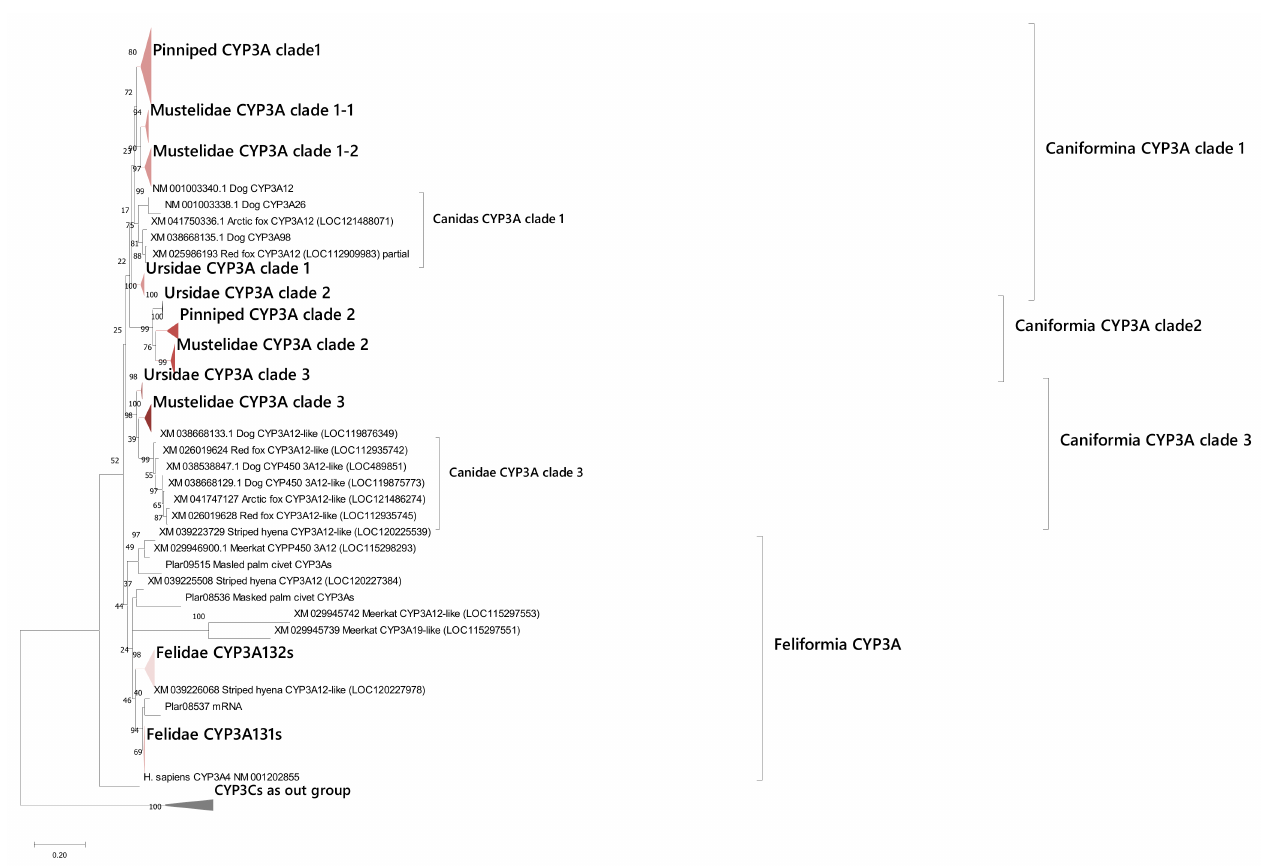
Figure 5. A phylogenetic tree of CYP3As. A phylogenetic tree of CYP3As sequences in carnivorans. Gene sequences of protein-coding regions for each isozyme were analyzed. The numbers next to the branches indicate the number of occurrences per 100 bootstrap replicates. Genes and clades are tentatively labeled with Carnivoran CYPs examined in this article. Caniformia clade 1, clade 2, clade 3, and Felidae CYP3A131s and 3A131s clades are shown with differently colored triangles. CYP3Cs are shown as an out